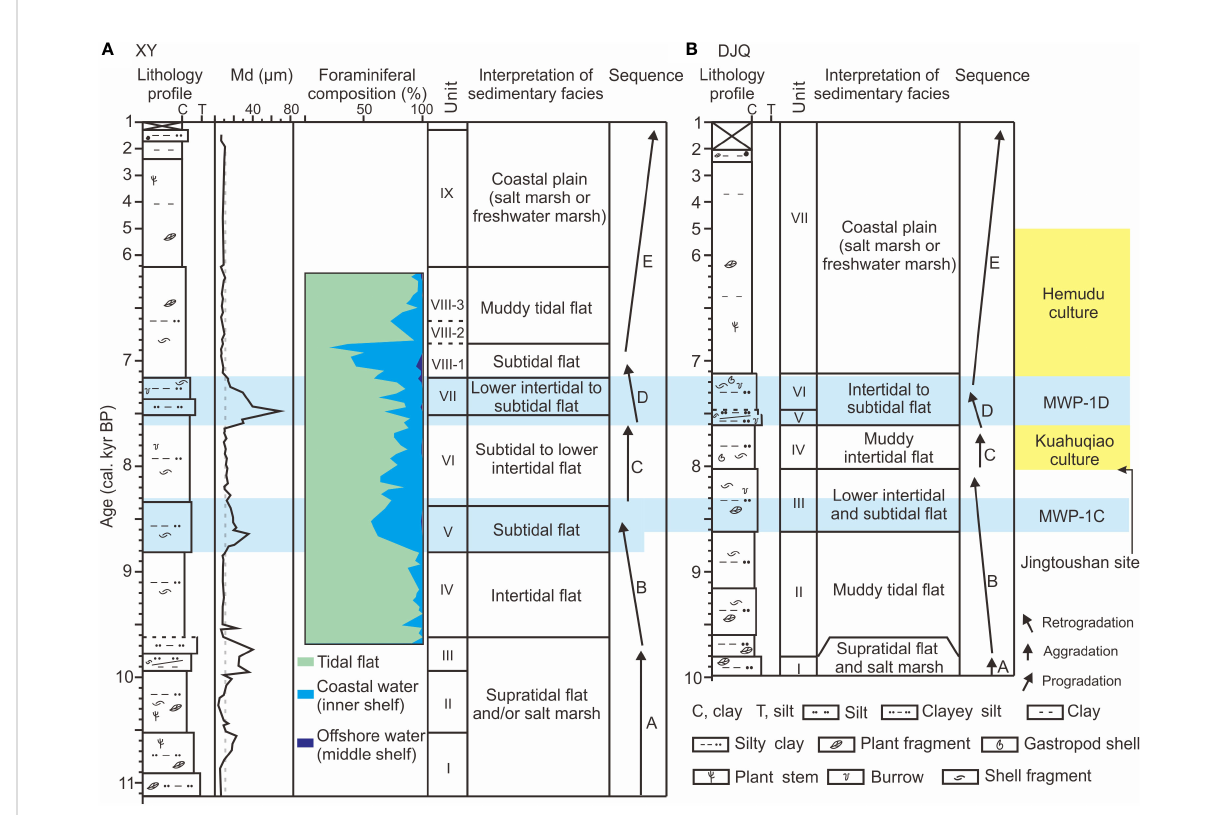
FIGURE 7 Comparison of temporal changes in lithology, grain size, foraminifera, and sedimentary facies, and interpretation of sequences between cores XY (A) and DJQ (B) . Also indicated are two major periods of strengthened transgression induced by the MWP-1C and MWP-1D events. Impact of MWP-1C commenced later at core site DJQ because of its more inland and sheltered location (Figures 1B, C). The Neolithic Kuahuqiao and Hemudu cultures developed during the periods of relative stable sea levels and the Neolithic Jingtoushan site of shell middens emerged at ca. 8 cal. kyr BP when aggradation of tidal fl at dominated in both